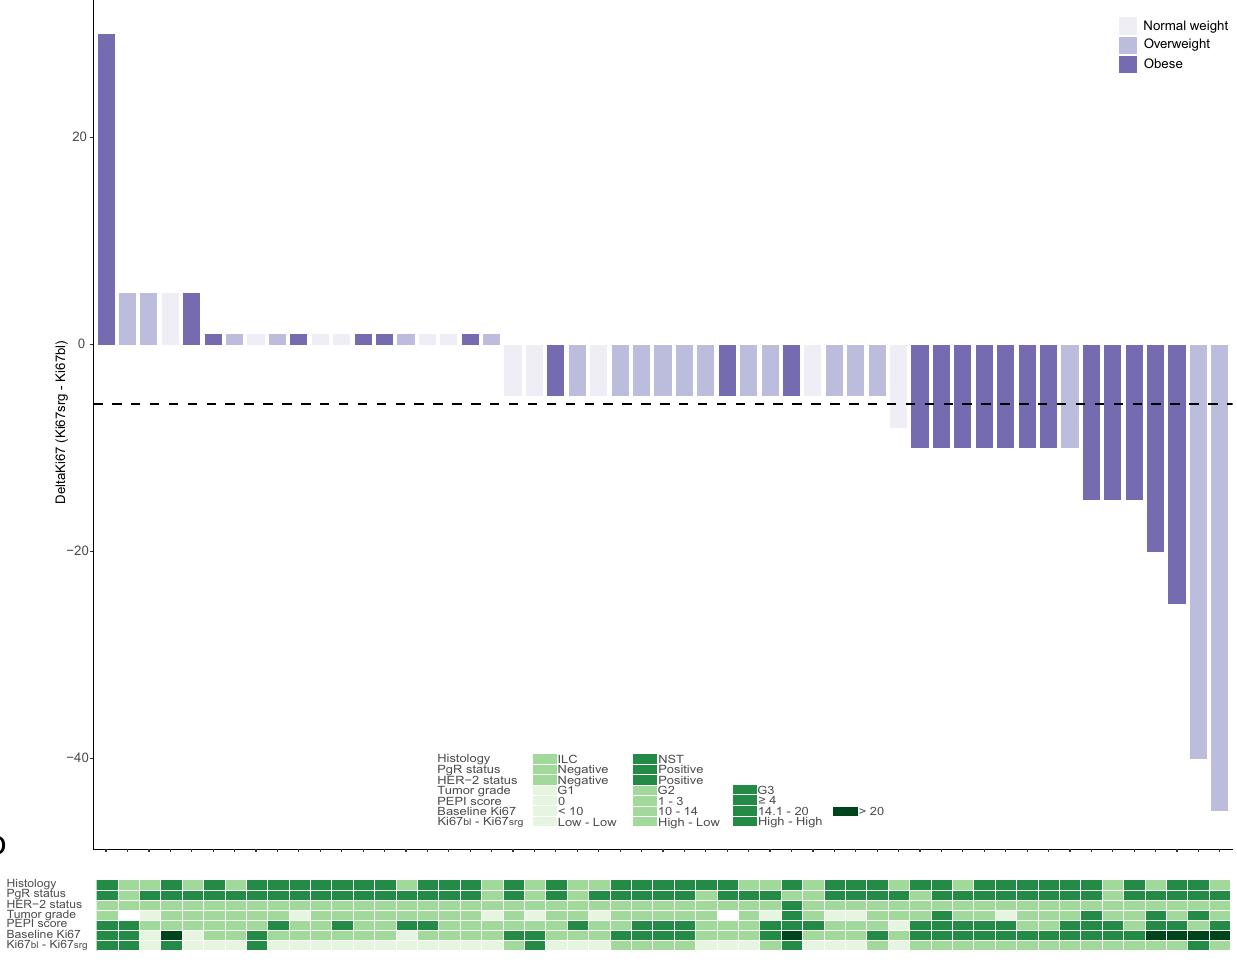
Fig. 1 Patient Ki67 suppression and tumor characteristics. a Patient Ki67 suppression ordered from low to high Ki67 suppression, expressed in percentage, is de fi ned as Ki67 srg -Ki67 bl . Each bar, representing a patient, is colored according to BMI category. The dashed line represents the arithmetic mean of Ki67 suppression. b Tumor characteristics by histology, baseline PgR status, baseline HER-2 status, baseline tumor grade, PEPI score, baseline Ki67 index, and “ Ki67 bl – Ki67 srg ” groups are indicated by colored boxes under each patient. BMI body mass index, HER-2 human epidermal growth factor receptor 2, Ki67 bl Ki67 at baseline, Ki67 srg Ki67 at surgery, ILC invasive lobular carcinoma, NST invasive carcinoma of no special type, PgR progesterone receptor status, PEPI preoperative endocrine prognostic